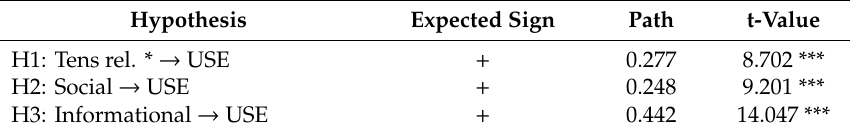
Table 4. Path coe ffi cients and t-value (structural